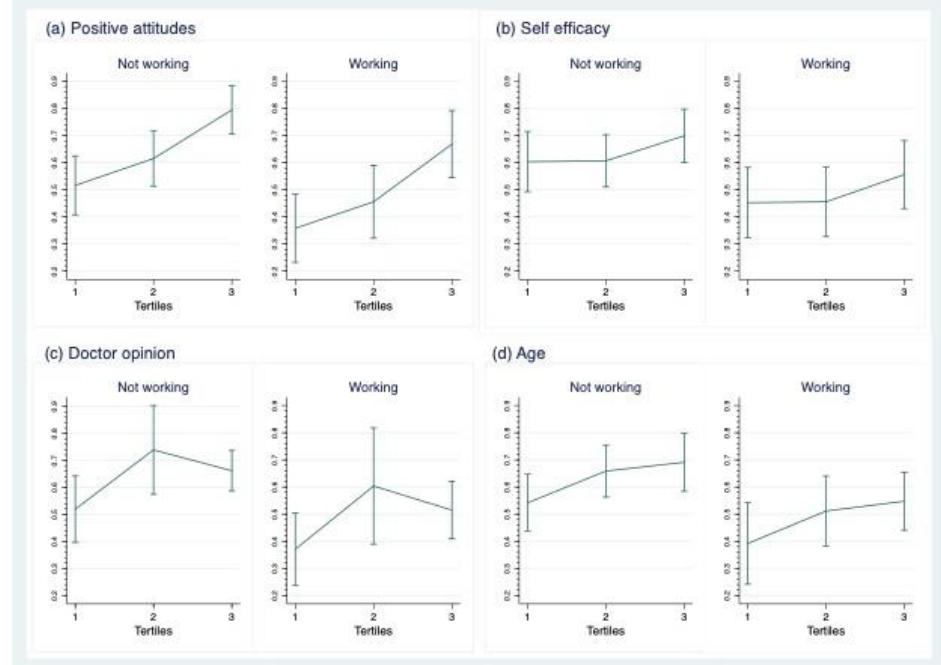
Figure 2. Predicted probabilities of exclusive breastfeeding intention (EBI) with 95% confidence interval by working status (WS). ( a ) Predicted probabilities of EBI at tertiles of positive attitudes scale by WS. ( b ) Predicted probabilities of EBI at tertiles of self-efficacy scale by WS. ( c ) Predicted probabilities of EBI at tertiles of doctor opinion scale by WS. ( d ) Predicted probabilities of EBI at tertiles of age group by WS.